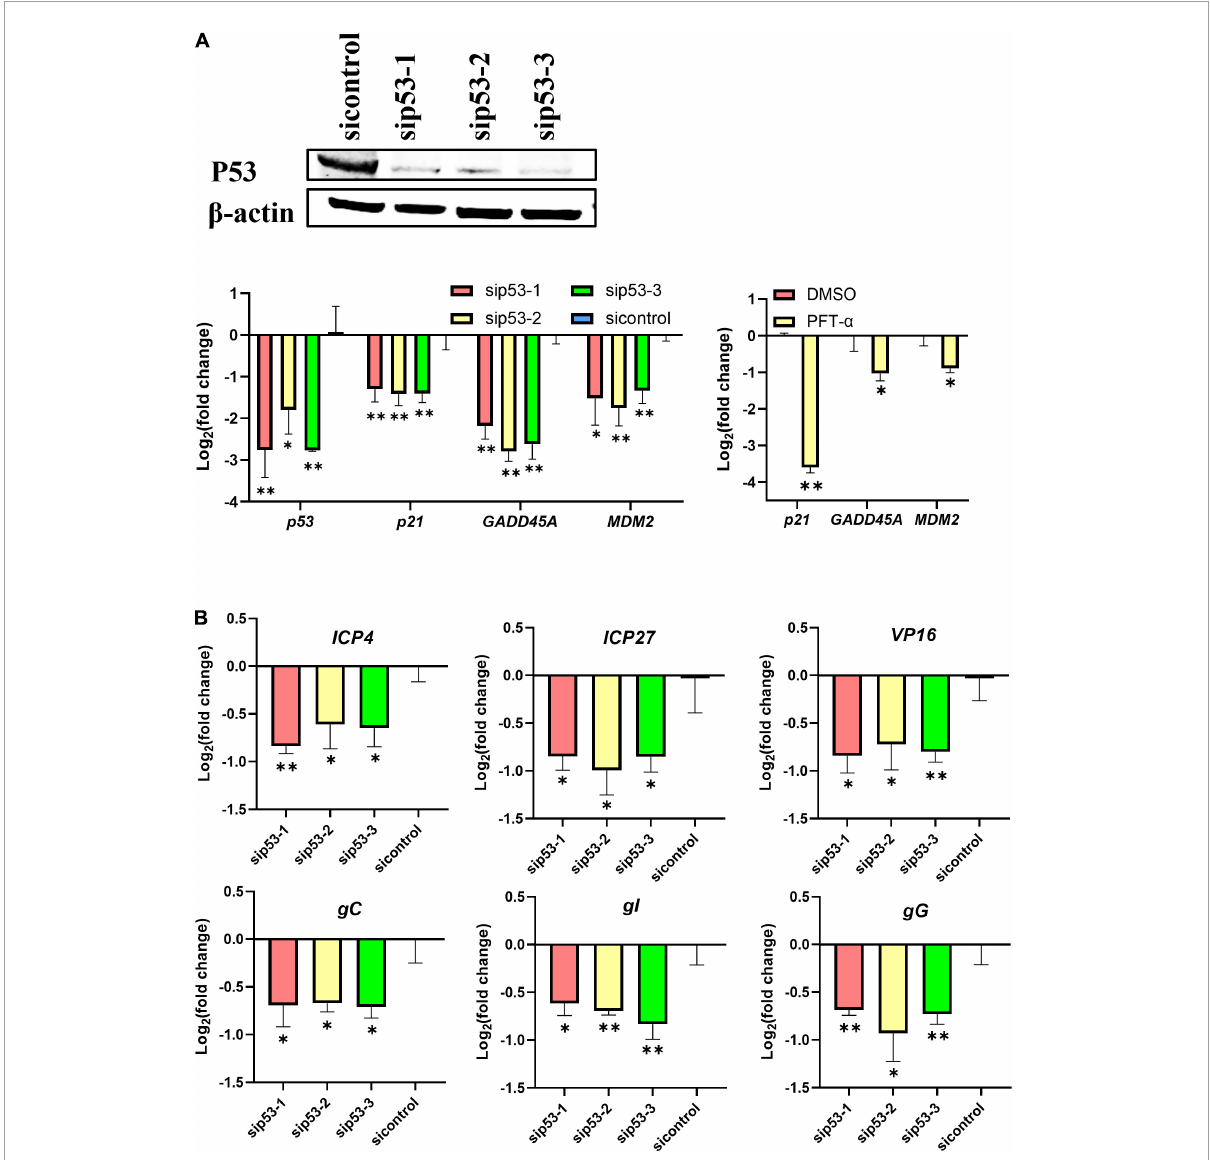
FIGURE1 P53 is a host determinant of ILTV gene transcription in LMH cells. LMH cells were transiently transfected with p53 siRNA (sip53) or negative control siRNA (sicontrol) for 24 h. (A) The knockdown efficiencies of p53 siRNA were analyzed by immunoblotting and RT-qPCR and the effect of PFT- α on p53 target genes were analyzed by RT-qPCR. (B) The transcription levels of six ILTV genes covering all stages of ILTV transcription, namely ICP4 , ICP27 , VP16 , gC, gI, and gG , in LMH cells were quantitated 6 h after ILTV infection (MOI = 1) using RT-qPCR. The results are presented as the mean ± SD, n = 3. * p < 0.05 and ** p < 0.01 indicated the levels of